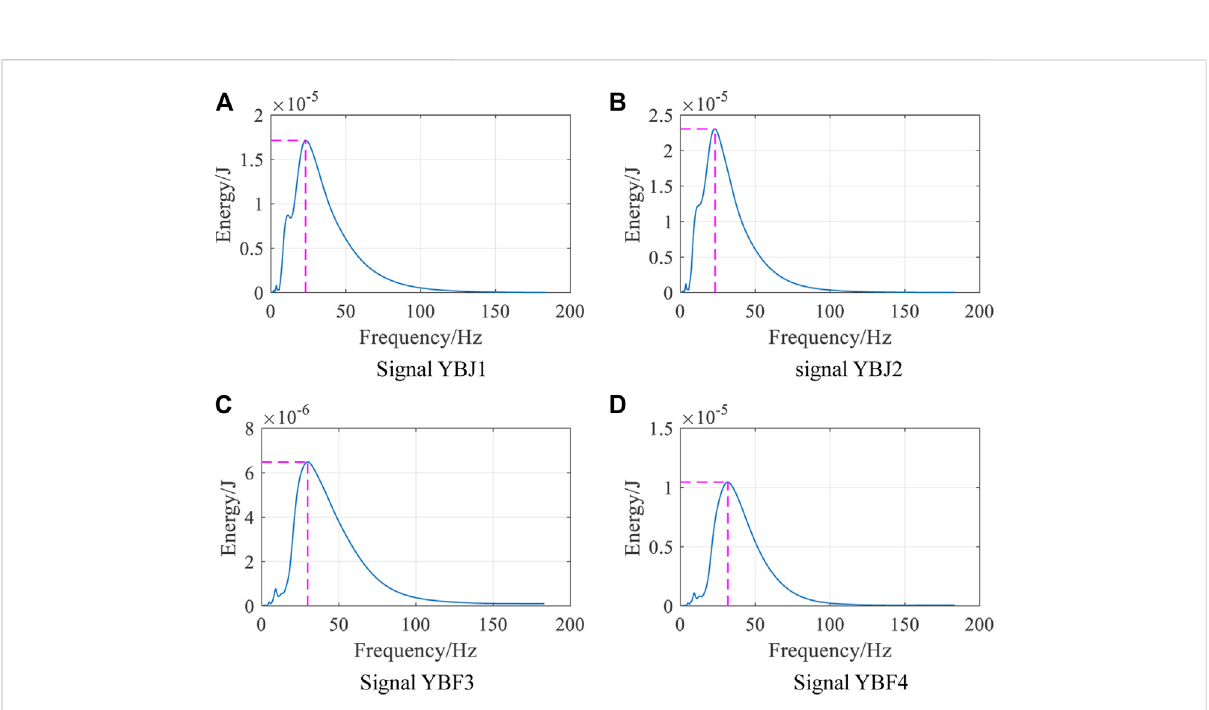
FIGURE 9 Scale energy spectrum of blasting vibration signals based on Blas2.4